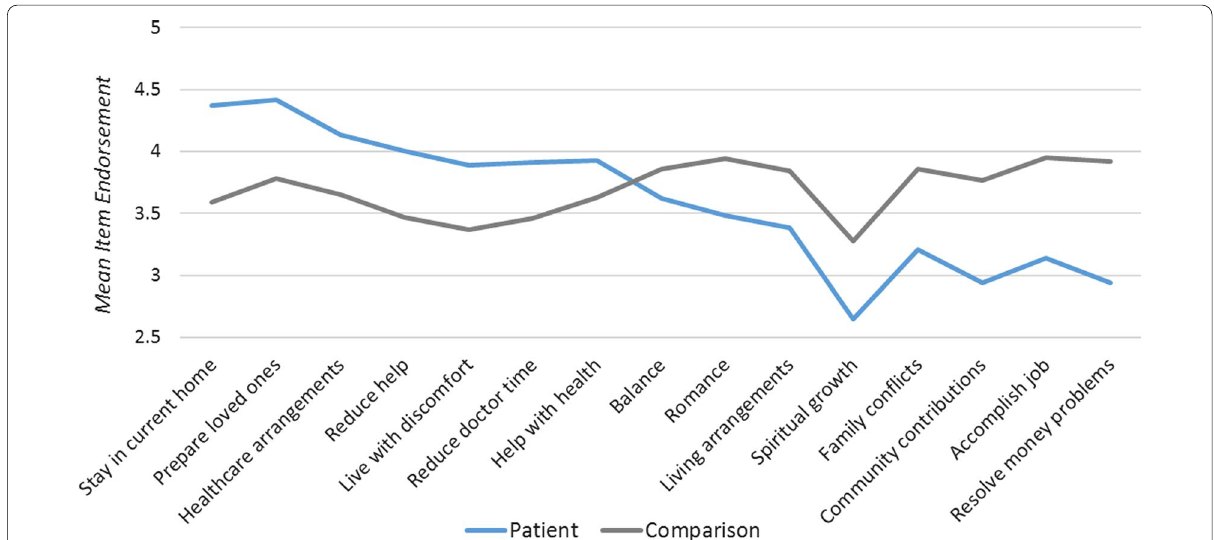
Fig. 1 Goal item endorsement by role. Unadjusted means are shown for patients (blue line) and comparison participants (grey line) on the close-ended goal items with the most substantial